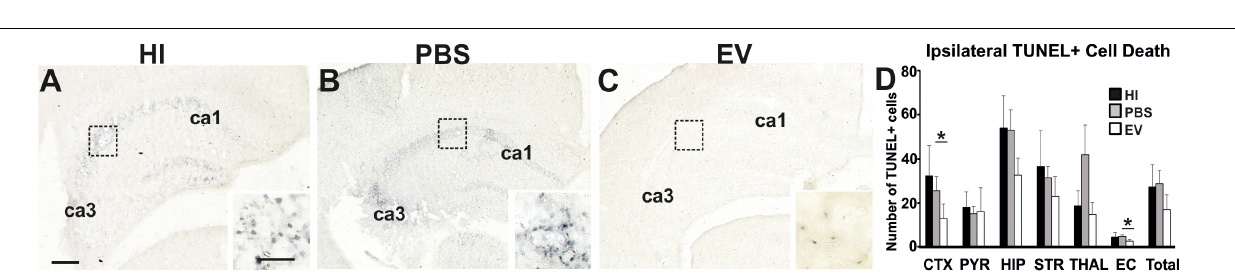
FIGURE 1 | Intranasal application of MSC-derived EVs, immediately following HI, significantly reduces microglial activation after 48 h. (A–C) Ipsilateral overview of early microglial activation in EV- and control treated animals. Note the strong microglial activation in the HI (A) and PBS-treated (B) groups with α M + cells showing phagocytic morphology at high magnification ( A,B – inserts, hippocampus), compared to the EV-treated brains exhibiting a ramified phenotype ( C – insert). The ca1 and ca3 areas of hippocampus are indicated for reference. (D) Intranasal EV treatment significantly reduced ipsilateral microglial activation score ( D , Mean + SEM) overall compared to control-treated groups (PBS or HI) (Kruskal–Wallis test, p = 0.0168; Dunn’s test EV vs. PBS ∗ p = 0.0175) with significant individual decrease in cortex (Kruskal–Wallis test, p = 0.0371; Dunn’s test EV vs. PBS ∗ p = 0.0319), hippocampus (Kruskal–Wallis test, p = 0.0451; Dunn’s test EV vs. PBS ∗ p = 0.0392), striatum (Kruskal–Wallis test, p = 0.0442; Dunn’s test EV vs. PBS ∗ p = 0.0376). CTX, cerebral iscocortex; PYR, pyriform cortex; HIP, hippocampus; STR, striatum, Thal, thalamus; EC, external capsule. Scale bars: A–C = 150 µ m; inserts = 15 µ m.